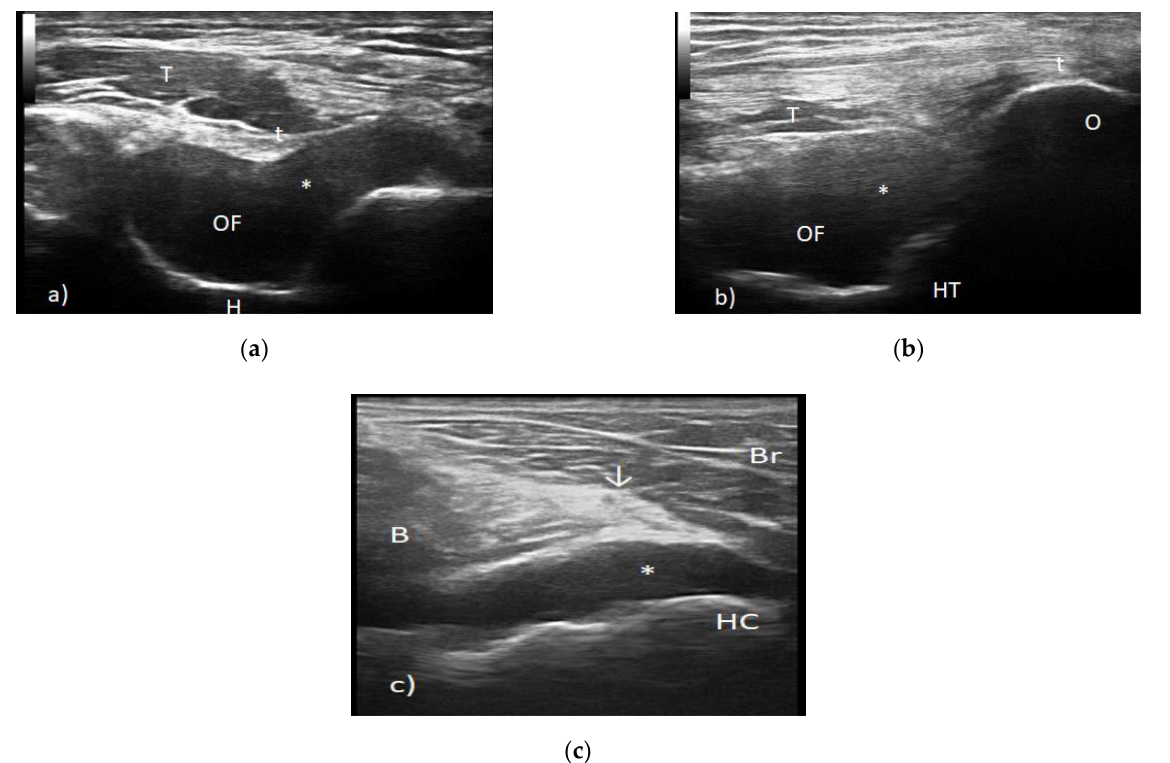
Figure 1. ( a ) Transverse scan posterior elbow. t—triceps tendon, T—triceps muscle, OF—olecranon fossa, *—synovial proliferation posterior joint recess and H—humerus. ( b ) Longitudinal scan posterior elbow. t—triceps tendon, T—triceps muscle, OF—olecranon fossa, *—synovial proliferation posterior joint recess and H—humeral trochlea. ( c ) Transverse view anterior elbow. B—brachialis muscle, Br—brachioradialis muscle, HC—humeral capitellum, ↓ —radial nerve and *—anterior joint recess synovitis.